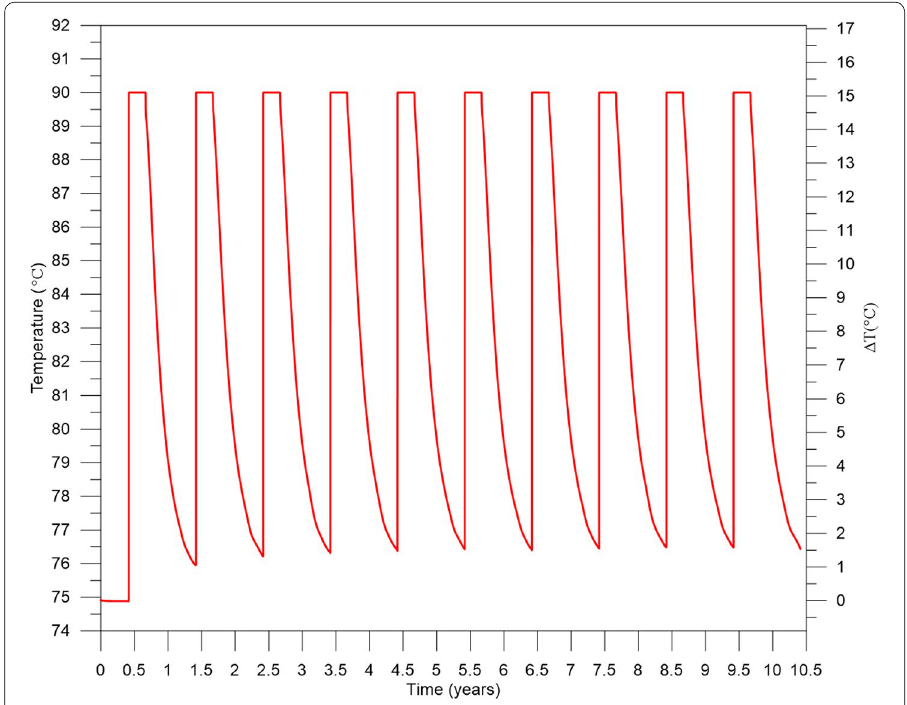
Fig. 6 Temperature history in P1 during a 10.4-year simulation with annual storage phase of 3